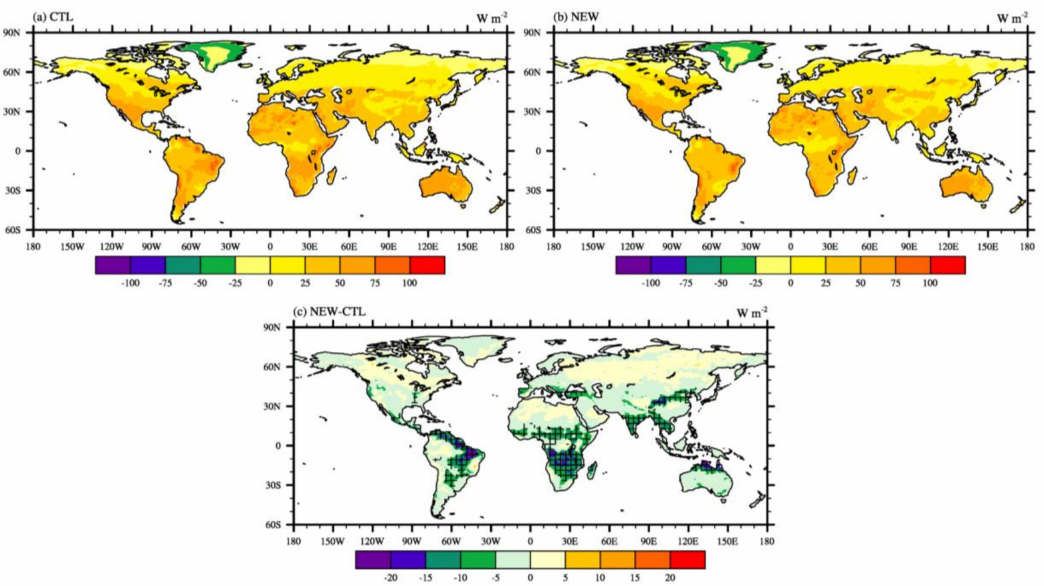
Figure 3. Annual sensible heat (SH, W m − 2 ) over 1982–2005 for ( a ) the CTL run; ( b ) the NEW run; ( c ) the difference between NEW and CTL. (Grid shaded regions are significant at the 95% confidence level according to Student’s t -test.).